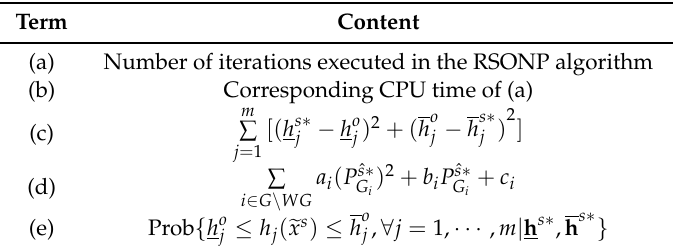
Table 1. The five terms evaluated in the test. RSONP: risk-limiting schedule of optimal non-renewable